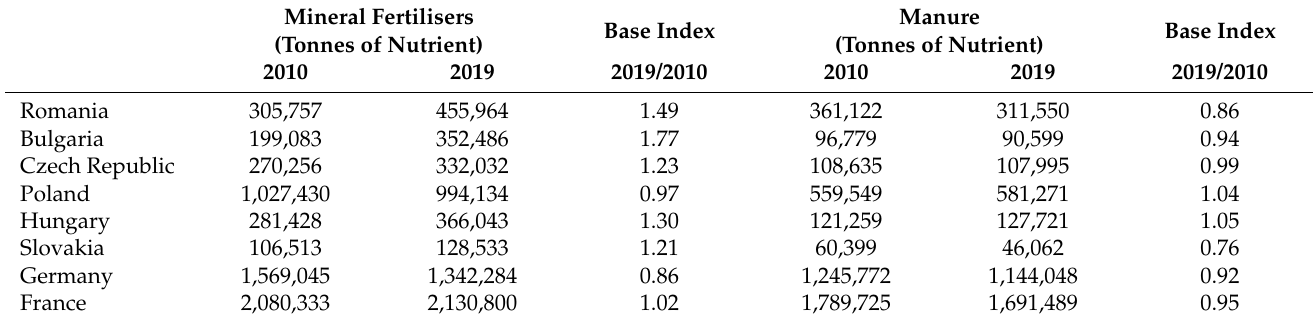
Table 1. Changes in mineral nitrogen fertiliser and manure consumption (2019/2010, tonnes of nutrient, base index). Source: own calculation based on